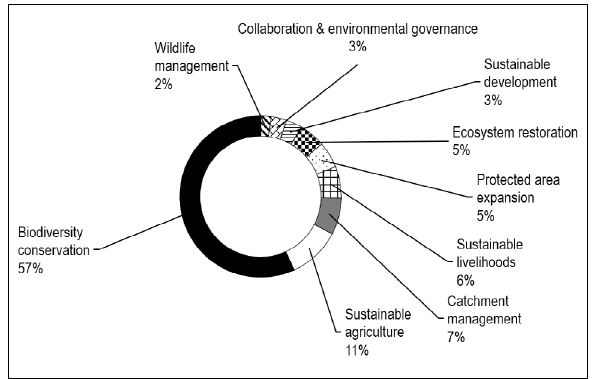
Primary objectives of stewardship initiatives ( n =95).